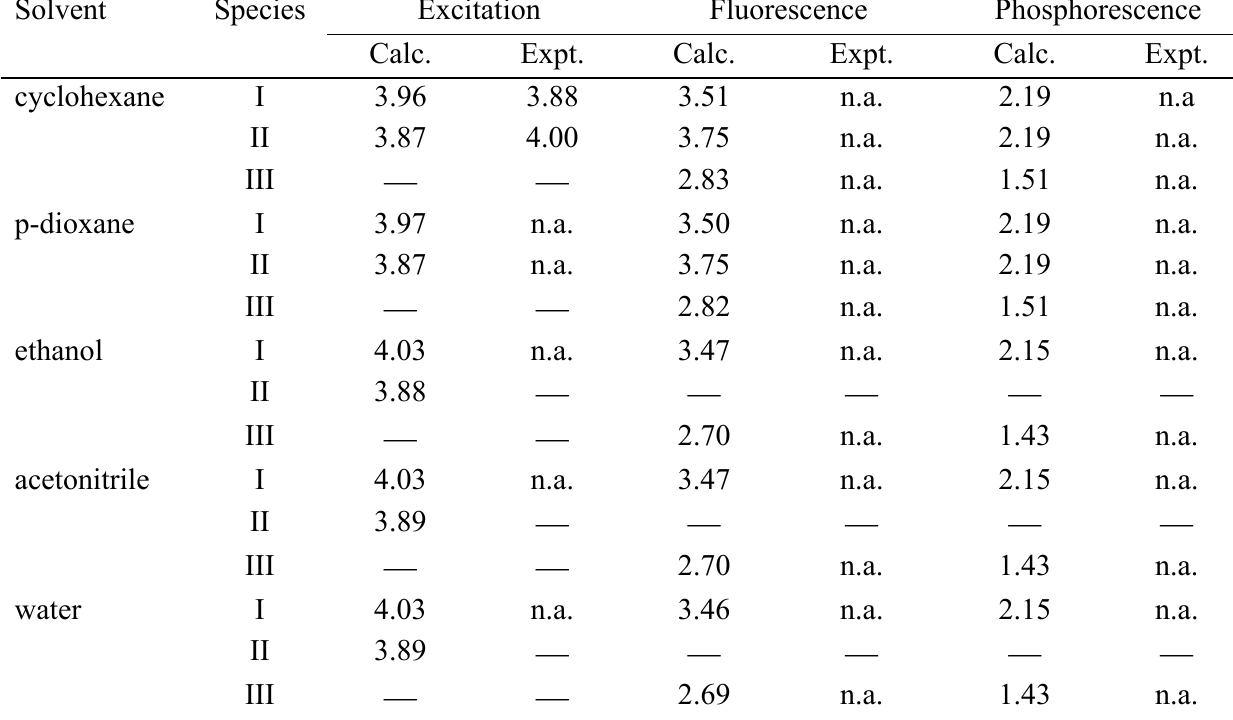
Table 13. Assignment of excitation, fluorescence and phosphorescence spectra of HPI in different solvents in terms of calculated energies (eV). Numbers within parentheses refer to the references corresponding to the experimental data. (n.a. indicates non-availability of data).